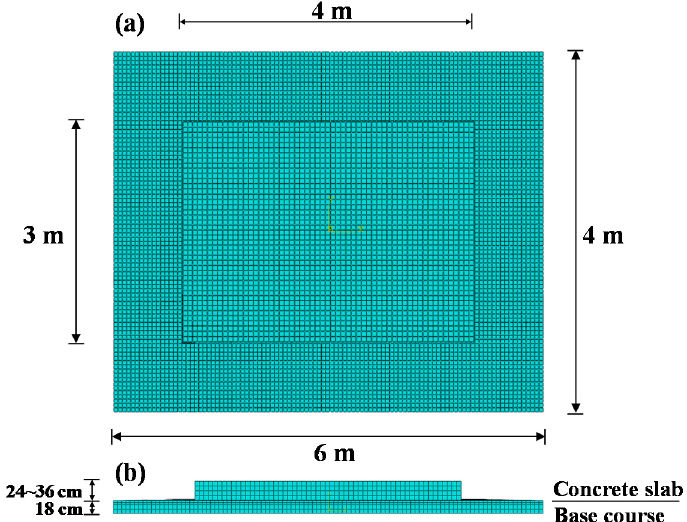
Figure 1. The FEA model of concrete pavement structure: ( a ) plane size of the model and ( b ) vertical size of the model.